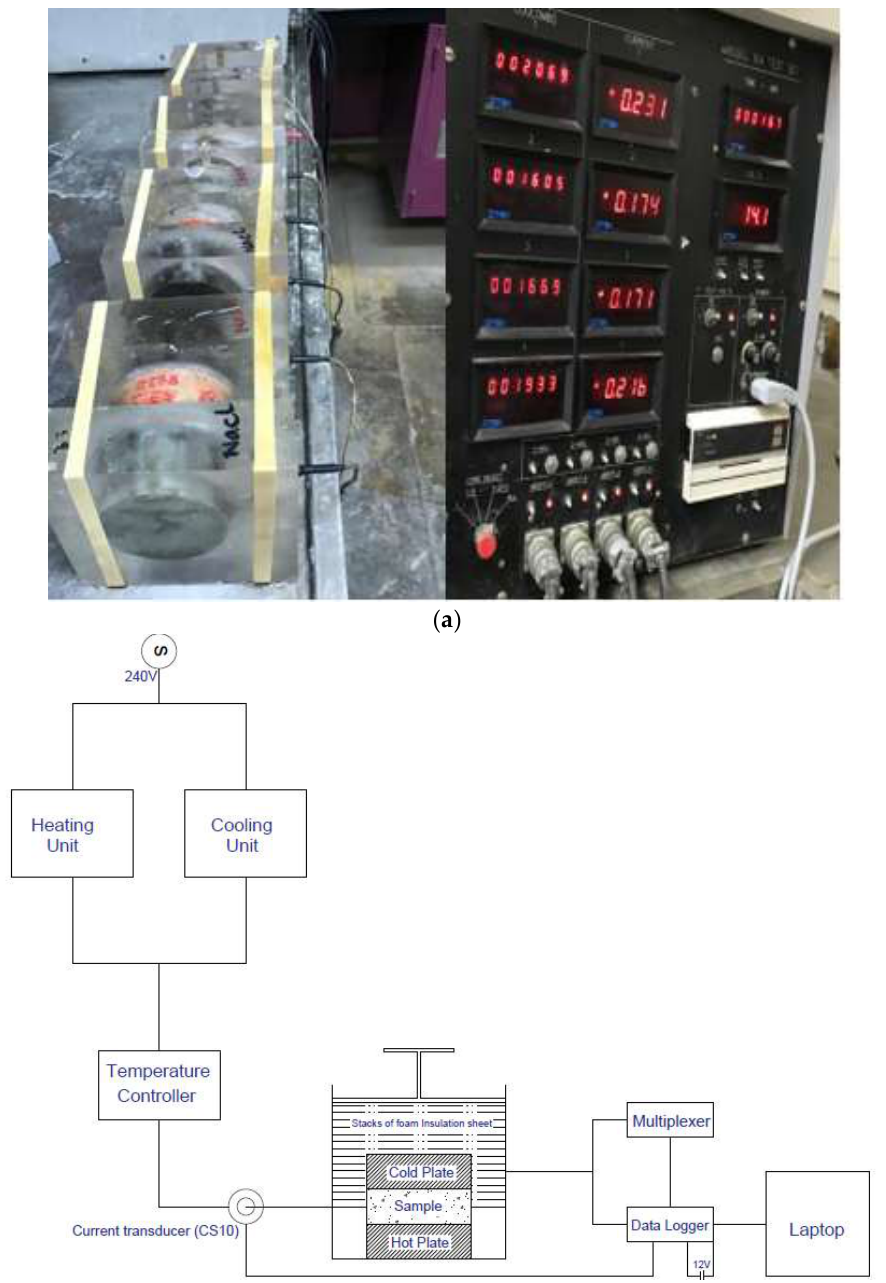
Figure 3. ( a ) Test setup for RCPT, and ( b ) schematic illustration for a thermal conductivity.